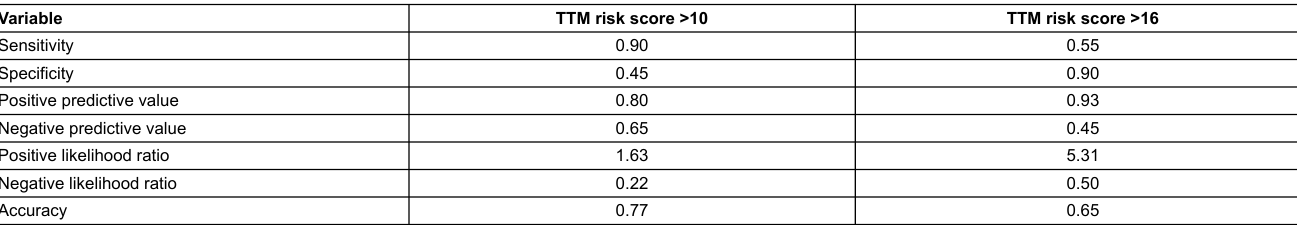
Table 3: Measures of diagnostic